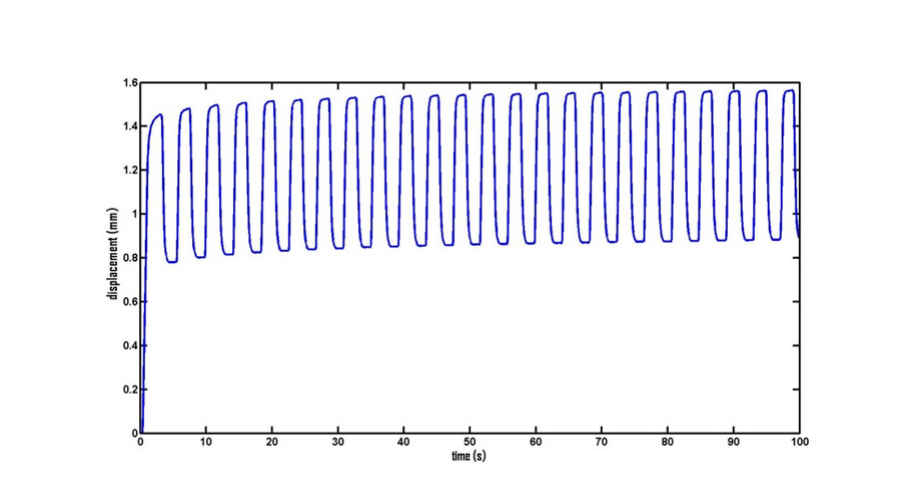
Fig. 8 Initial cycles of test at 40 ⁰ C with a hold time of 1s.